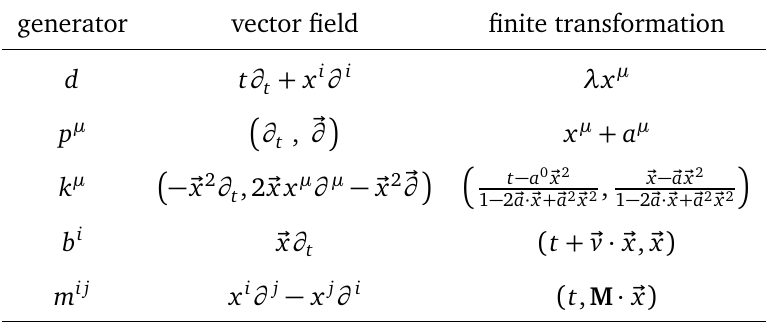
Table 1: Action of CCA symmetry generators as the vector fields on the space-time.